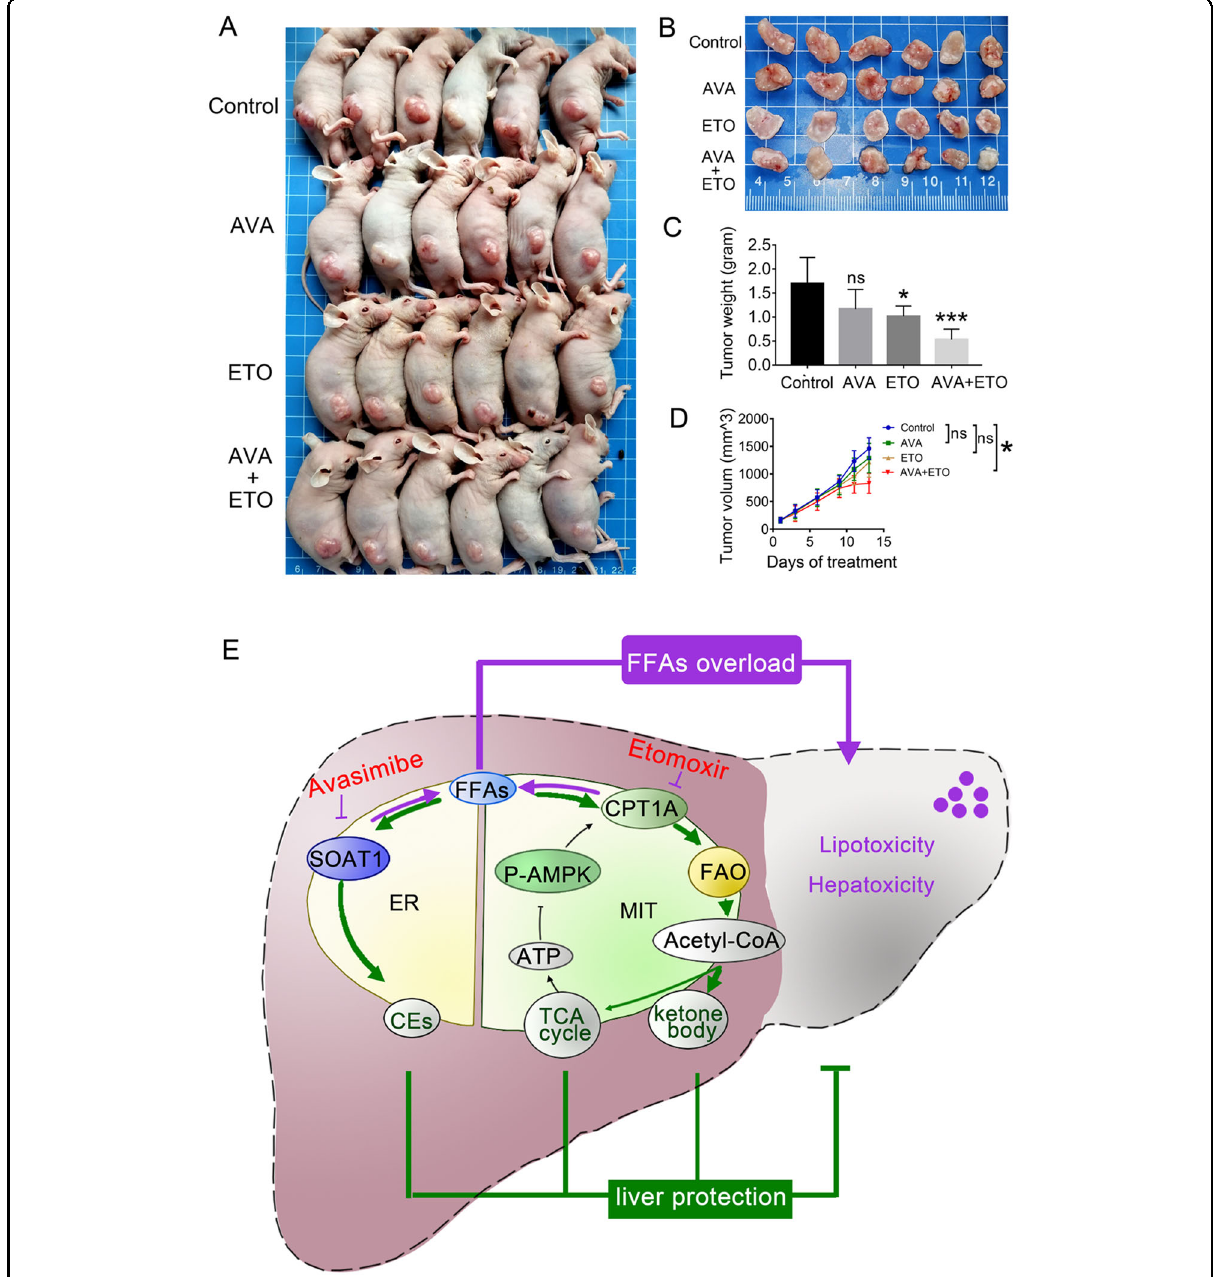
Fig. 8 Avasimibe and etomoxir augmented anti-cancer activity in HCC xenograft mouse model. A – B A combination of avasimibe and etomoxir effectively inhibited tumor growth. C Tumor weights on the fi nal day. D Tumor growth curves in mouse xenograft models treated with avasimibe (15 mg kg − 1 day − 1 ), etomoxir (10 mg kg − 1 day − 1 ), or both. Circle and triangle denote the average volume of tumors (mean± SEM, n = 8). E A mechanism graph illustrating how SOAT1 and CPT1A regulate lipid homeostasis to avoid lipotoxicity in HCC. SOAT1 and CPT1A balance excess FFAs by converting them in ER to form lipid drops and in mitochondria for oxidation. If one of the two fatty acids degradation pathways is blocked, another pathway is activated to maintain lipid homeostasis. Simultaneously targeting SOAT1 and CPT1A by the small-molecule inhibitors avasimibe and etomoxir had synergistic anticancer ef fi cacy by disrupting lipid homeostasis. ER endoplasmic reticulum, MIT